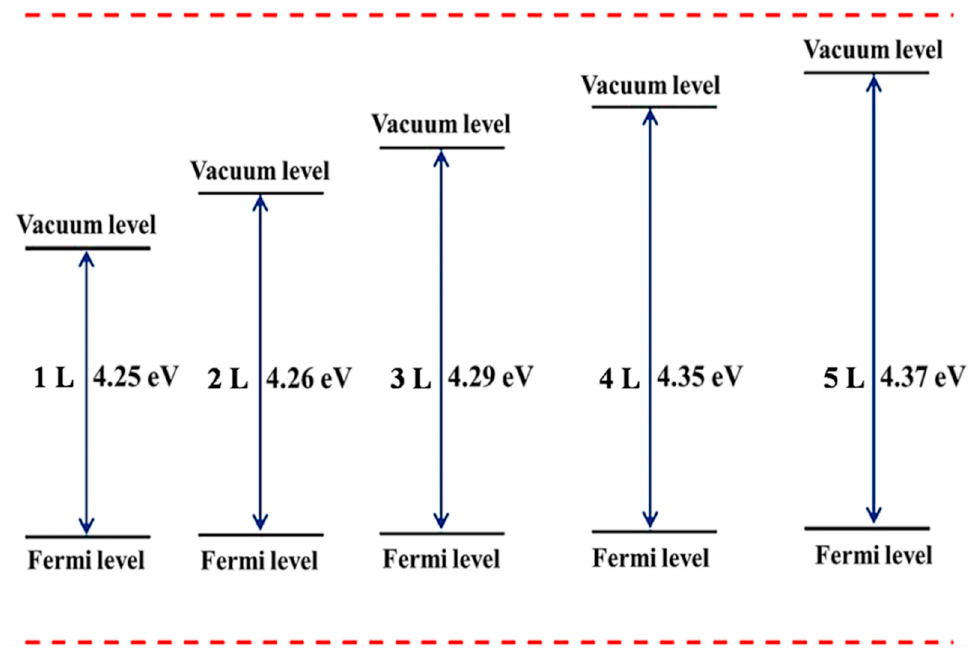
Figure 9. The work function schematic of monolayer and few-layer Te.